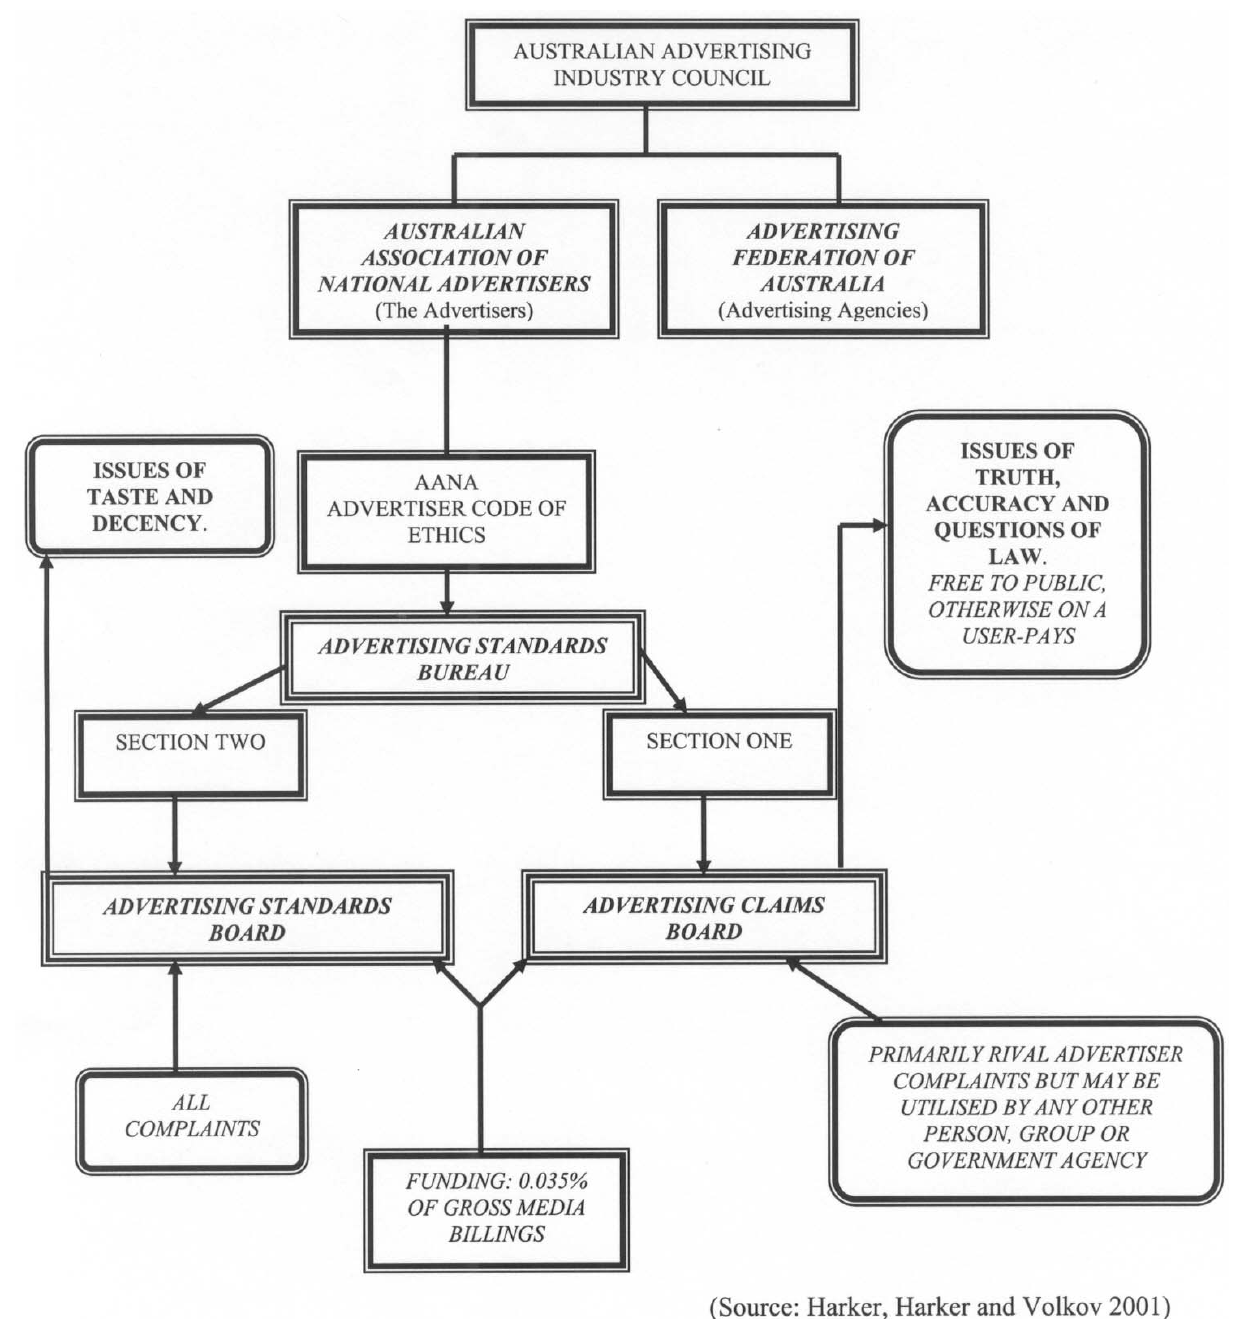
Figure 2: The structure of advertising self-regulation in